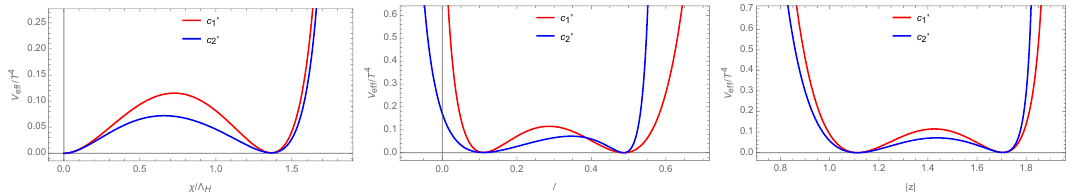
Figure 13 . The potential V e(cid:11) ( L; (cid:31); T ) =T 4 at T c; 6 = (cid:3) H = 2 : 918 as a function of (cid:31) (left), ‘ (center) and j z j (right) on the two di(cid:11)erent lines c 0 given in (3.74) and (3.75).